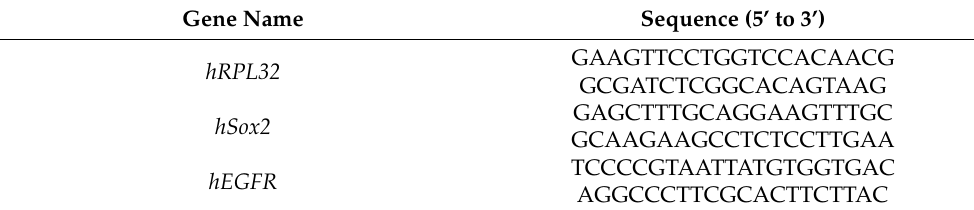
Table 1. Primer sets used in quantitative